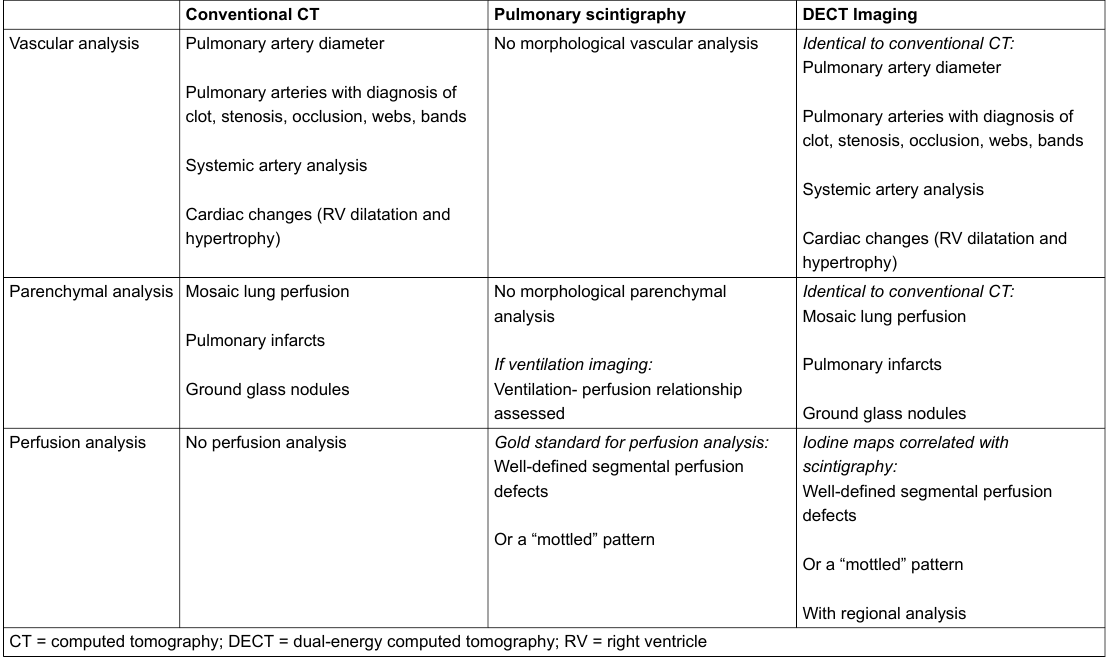
Table 2: Comparison between conventional CT, pulmonary scintigraphy and DECT imaging for pulmonary hypertension imaging assessment.